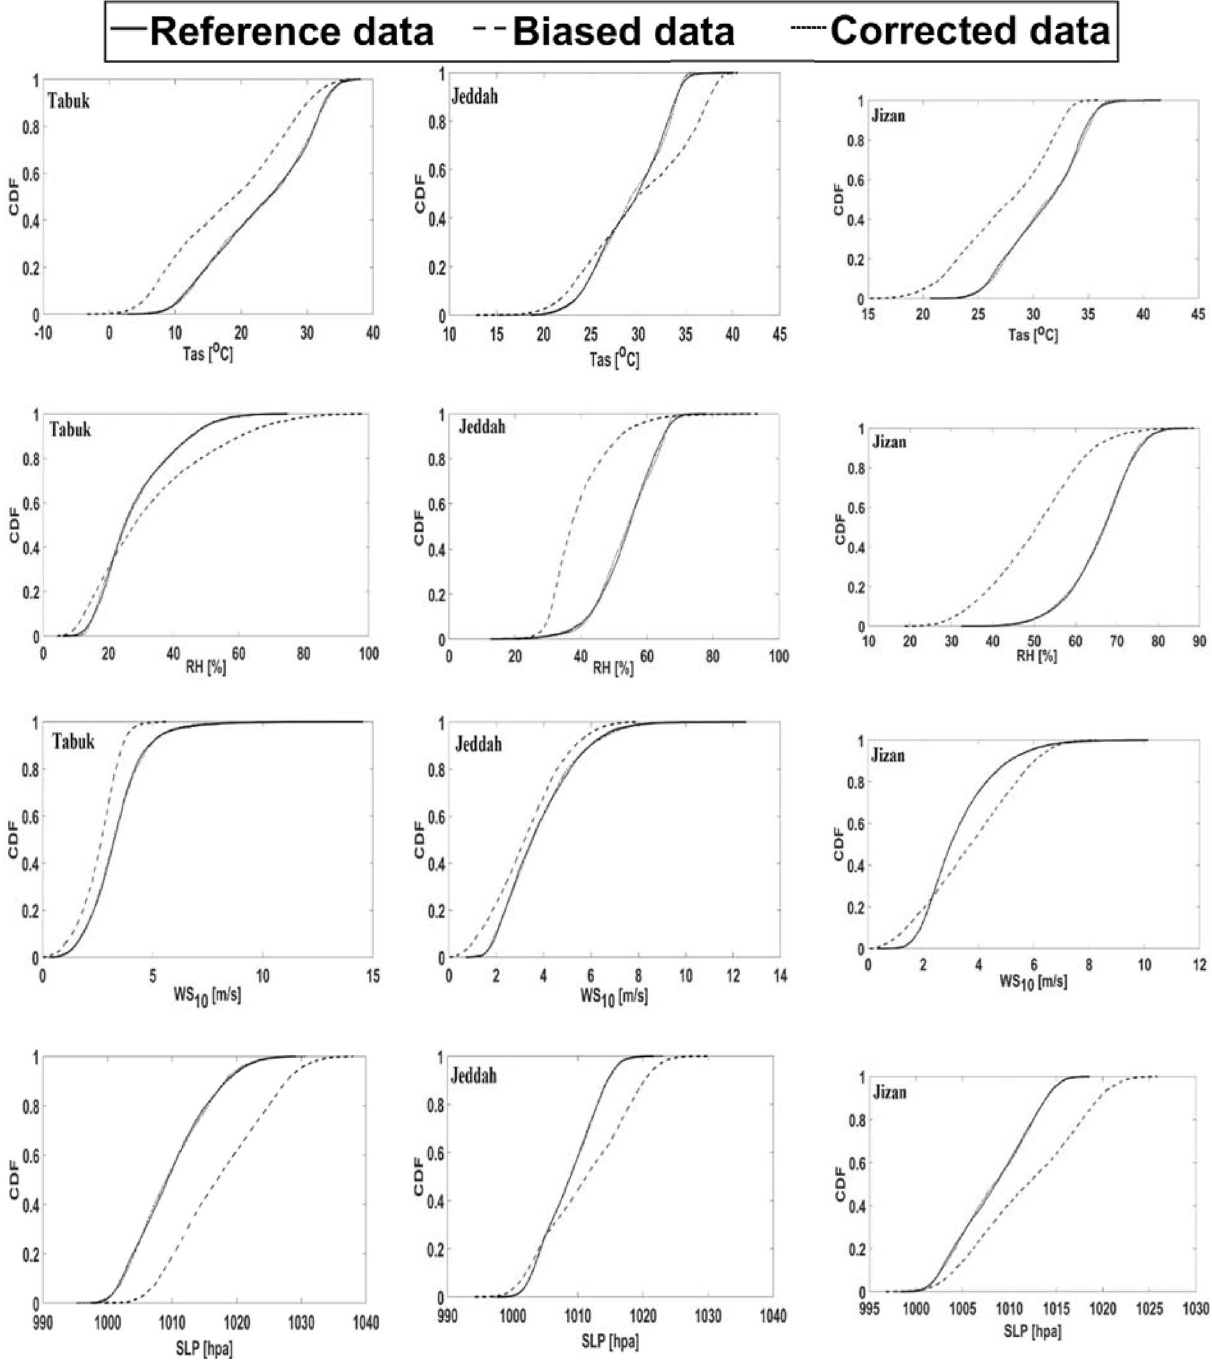
Figure 11. Cumulative distribution function (CDF) between the corrected ERA5 (C_ERA5) and GFDL mini- ensemble mean data over the control period (2006–2020) under the RCP2.6 scenario for the studied parameters. Tas (simulated 2-m air temperature), RH (relative humidity), surface wind speed (WS 10 ), and SLP (mean sea level pressure). The corrected data curves are identical to the reference curves. Math Works, Inc.